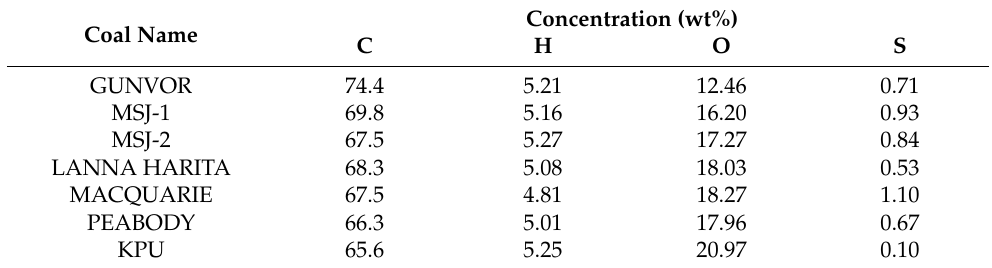
Table 1. Description of coal sample.